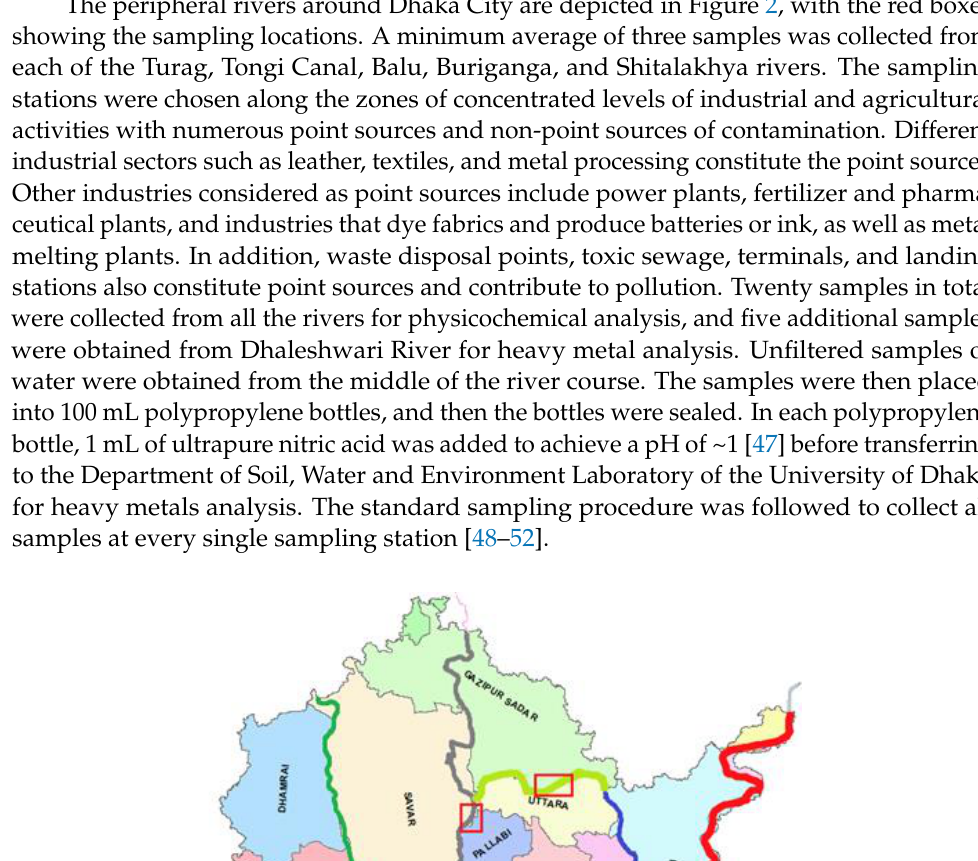
Table 1. Identification of sampling stations and distance from D-1 in Dhaleshwari River. Sampling Stations